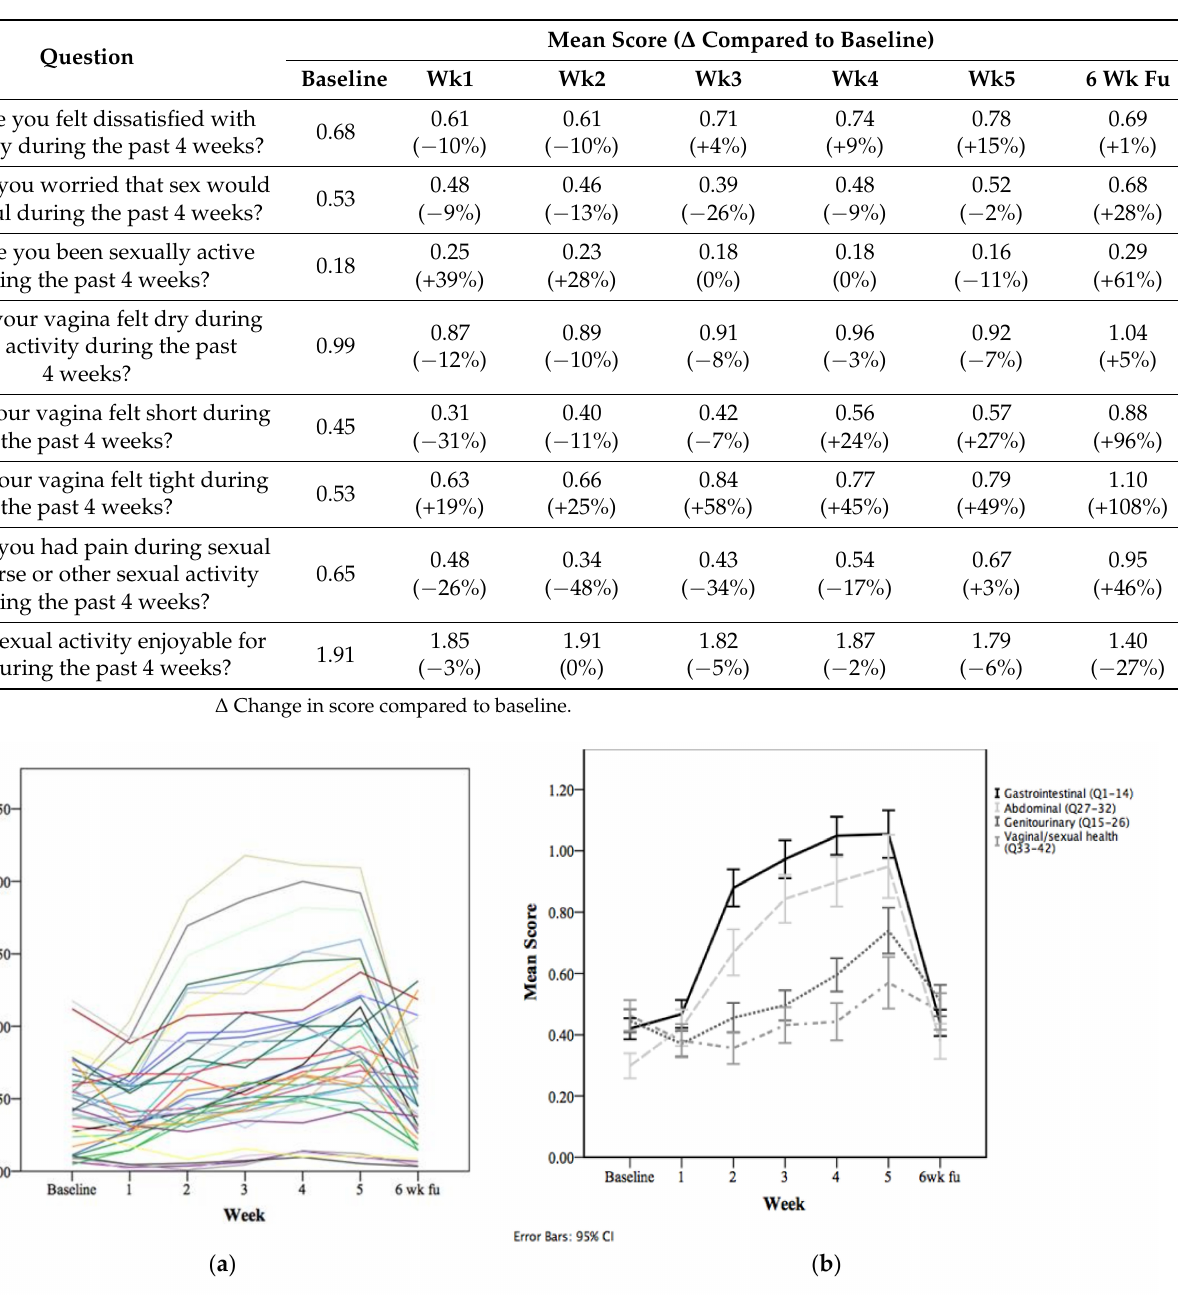
Figure 1. ( a ) Acute toxicity pattern of onset and resolution of symptoms is shown through mean question score, week by week. Each line represents a question. ( b ) This is confirmed from a sys- tems